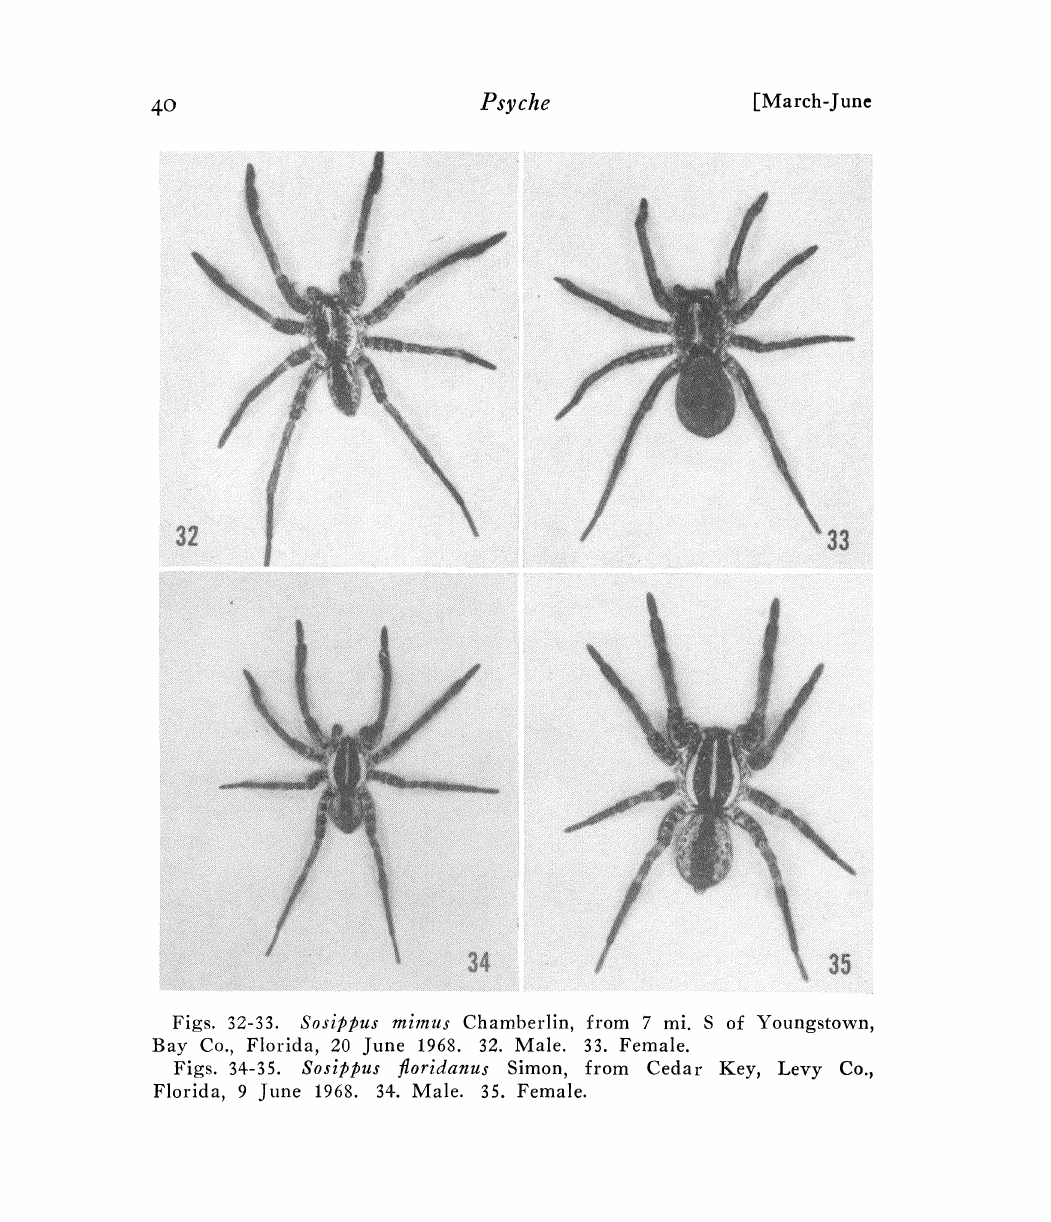
Figs. 32-33. Sosippus mimus Chamberlin, from 7 mi. S of Youngstown, Bay Co., Florida, 20 June 1968. 32. Male. 33. Female. Figs. 34-35. Sosippus floridanus Simon, from Cedar Key, Levy Co., Florida, 9 June 1968. 34. Male. 35.